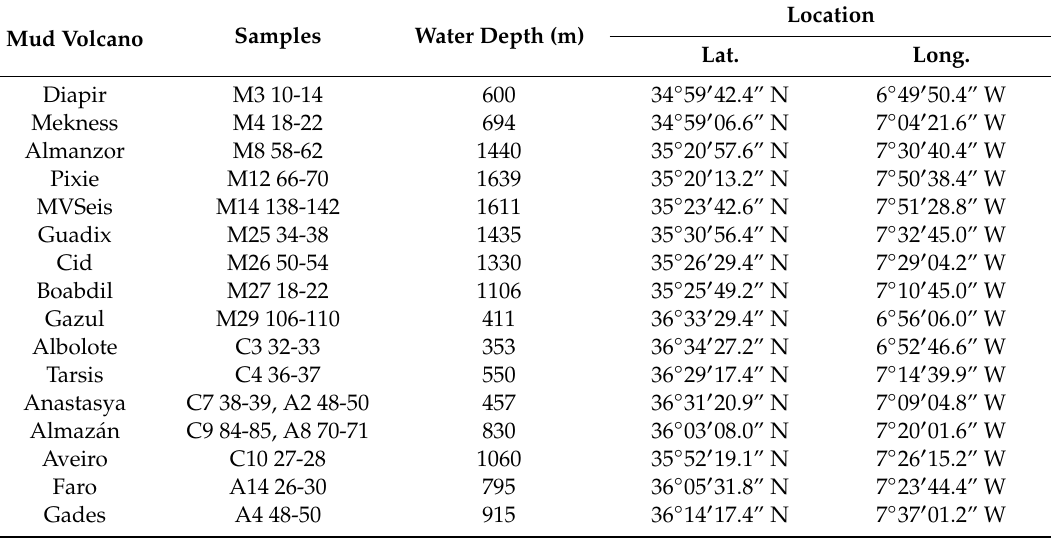
Table 1. Geographical position of the MVs sampled in the framework of this study. All M3 samples correspond to a diapiric structure, not a mud